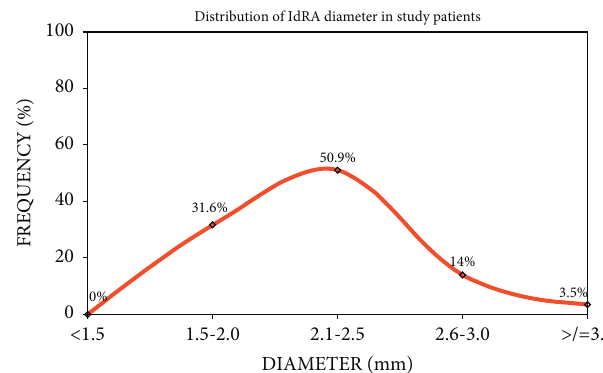
Figure 5: Left distal radial artery diameter among patients. Table 2: Outcomes of